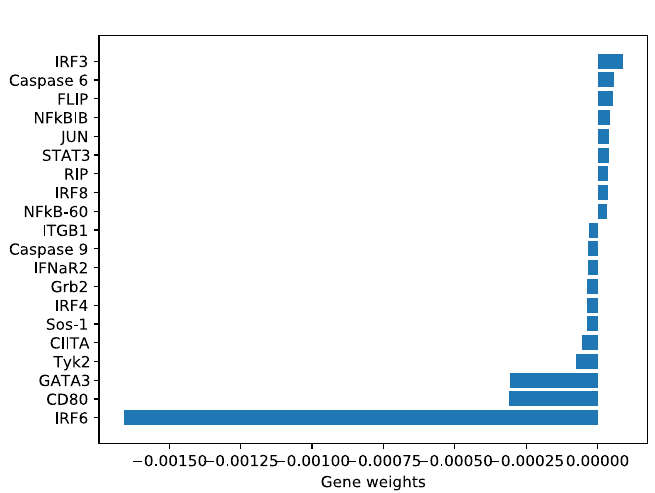
Figure 3. Top 20 genes in Dataset1 selected by REP-SVM according to their weights in u in (12) learned from the training set corresponding to